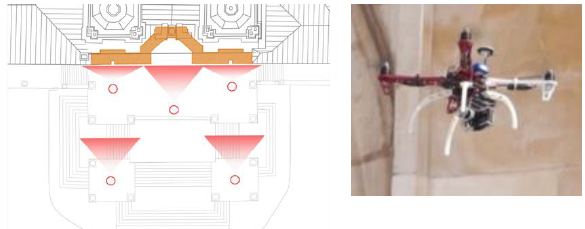
Figure 13. Drone used and location of the five flight stations for photographic survey of the facade of the monastery of Alcobaça (Coelho, Genin,